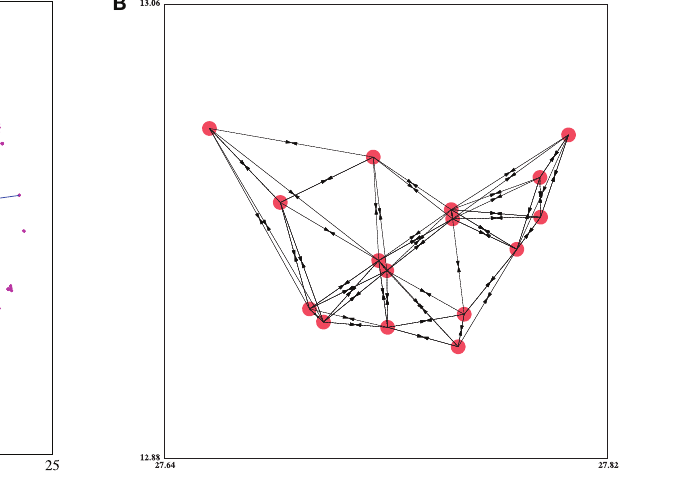
FIGURE 13 | (A) Positions of a flock of N = 512 agents with n = 5 neighbors in the interaction zone and at four different time instants: 100 (black), 200 (red), 300 (green), and 400 (magenta). The RGG has been updated at every time step. Three individual agents’ straight line trajectories have also been shown. There are a total of 29 clusters. (B) The sub-graph of the RGG